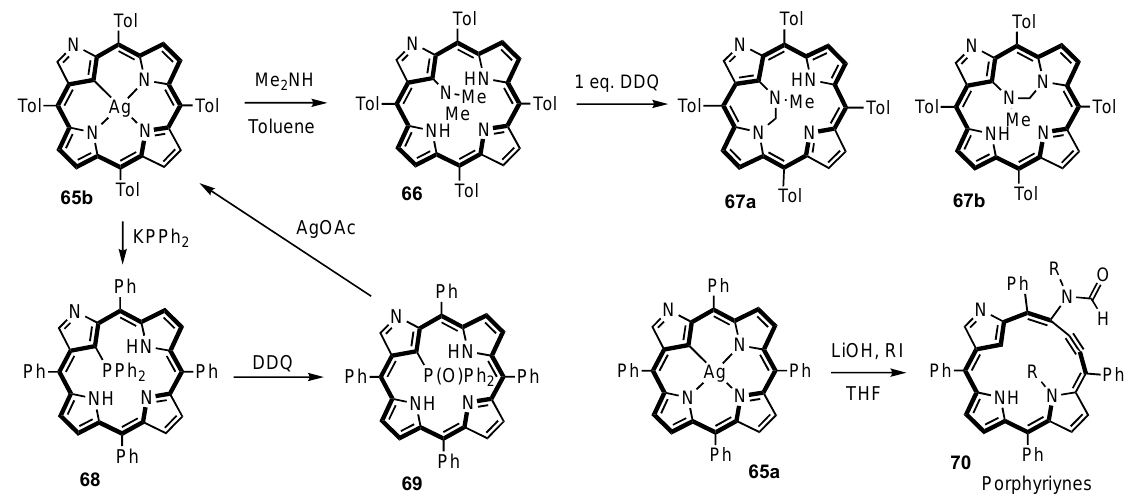
Scheme 15. Synthesis of new porphyrinoids from silver(III) NCPs.